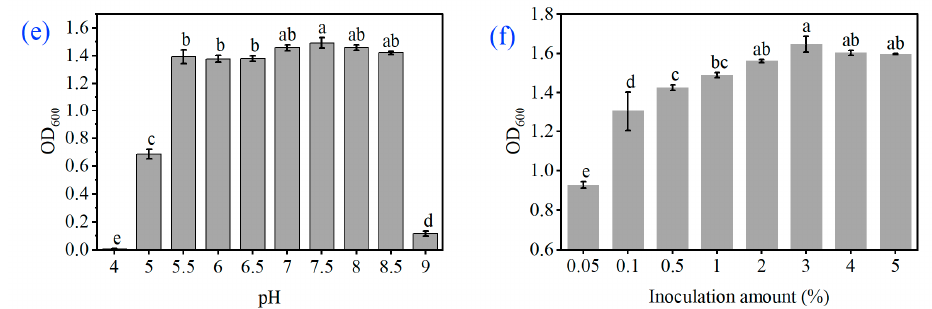
Figure 4. The results of the biological characteristics of the strain WM6 revealed ( a ) the effects of different carbon sources on the growth of the strain; ( b ) the effects of different nitrogen sources on the growth of the strain; ( c ) the effects of different inorganic salts on the growth of the strain; ( d ) the influence of different temperatures on the growth of the strain; ( e ) the influence of different pH on the growth of the strain; and ( f ) the influence of different inoculum on the growth of the strain.